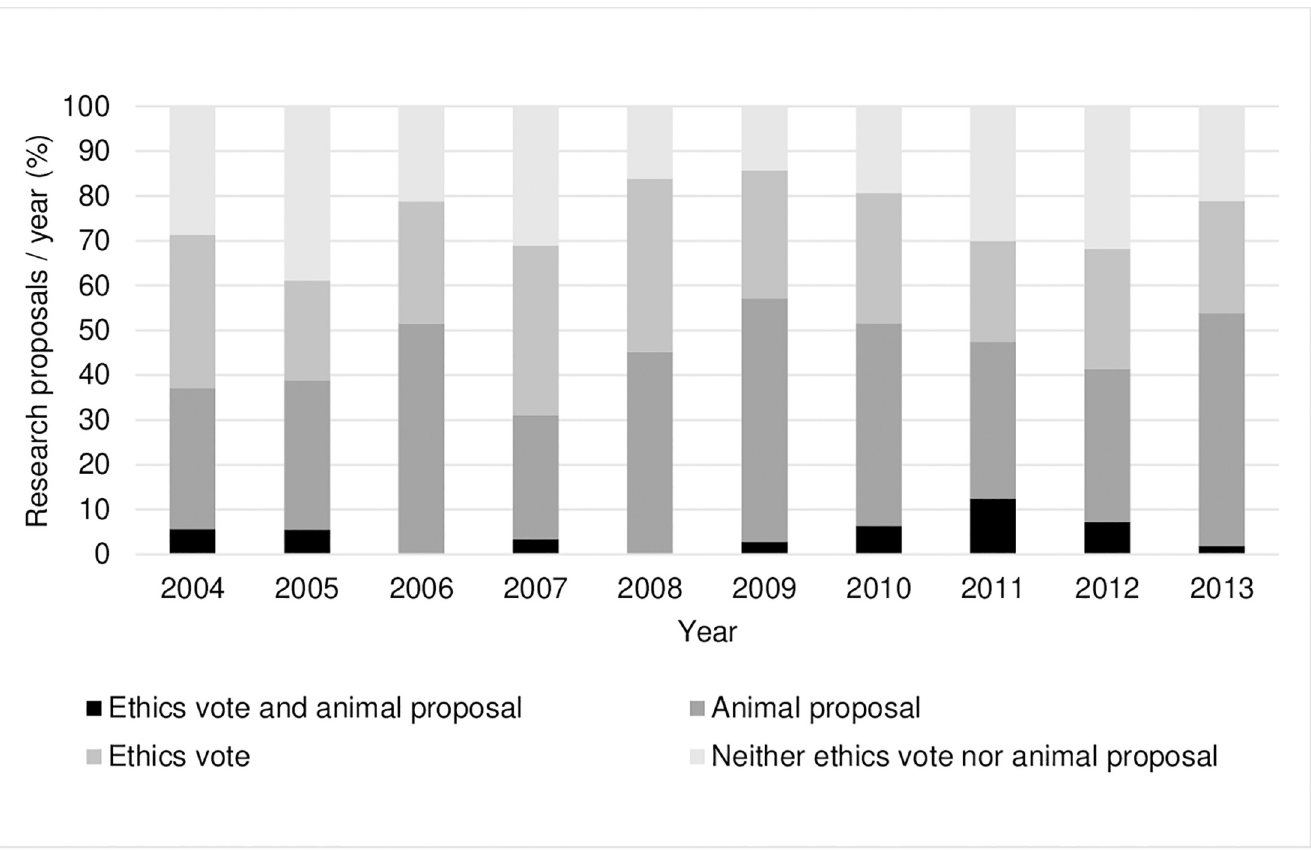
Fig 1. Percentages of approved research proposals that required an ethics vote and/or an animal proposal or neither ethics vote nor animal proposal for each year within the ten-year period.